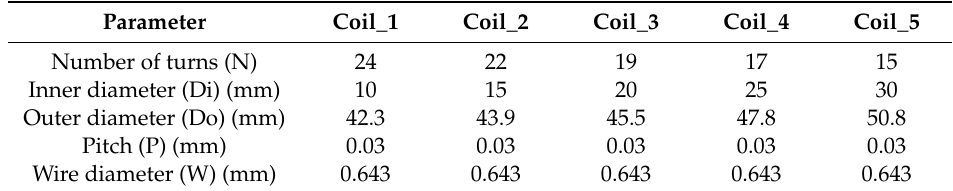
Figure 5. Circular, flat spiral, air-core single coil geometry.